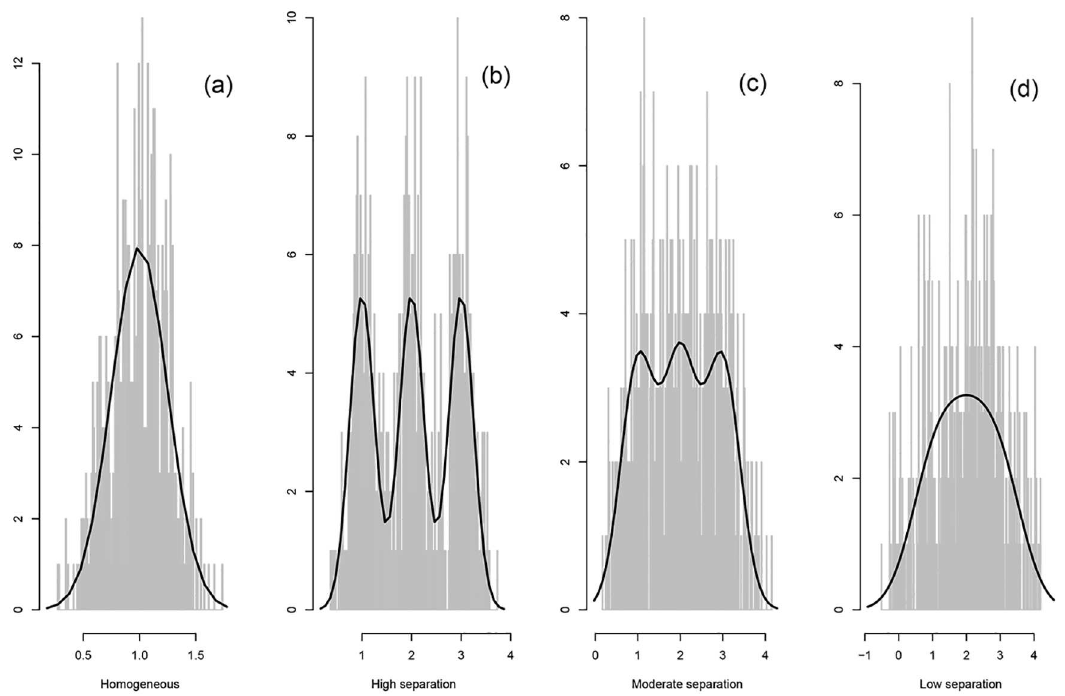
Fig 1. Univariate simulated data study. Histograms of randomly selectedgenerateddata sets. The solid lines represent the true marginaldensities.